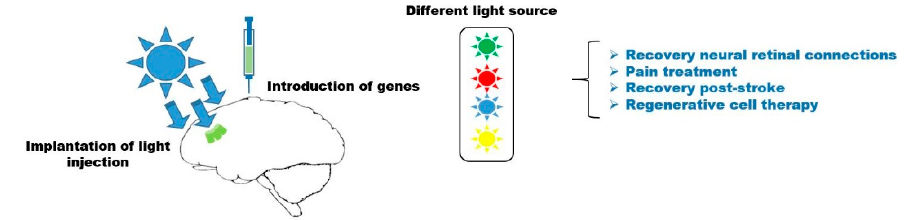
Figure 2. Strategic applications of Optogenetics strategy in different neurological diseases: different light sources, together with the introduction of specific genes, may have different outcomes that lead to different possible clinical applications.